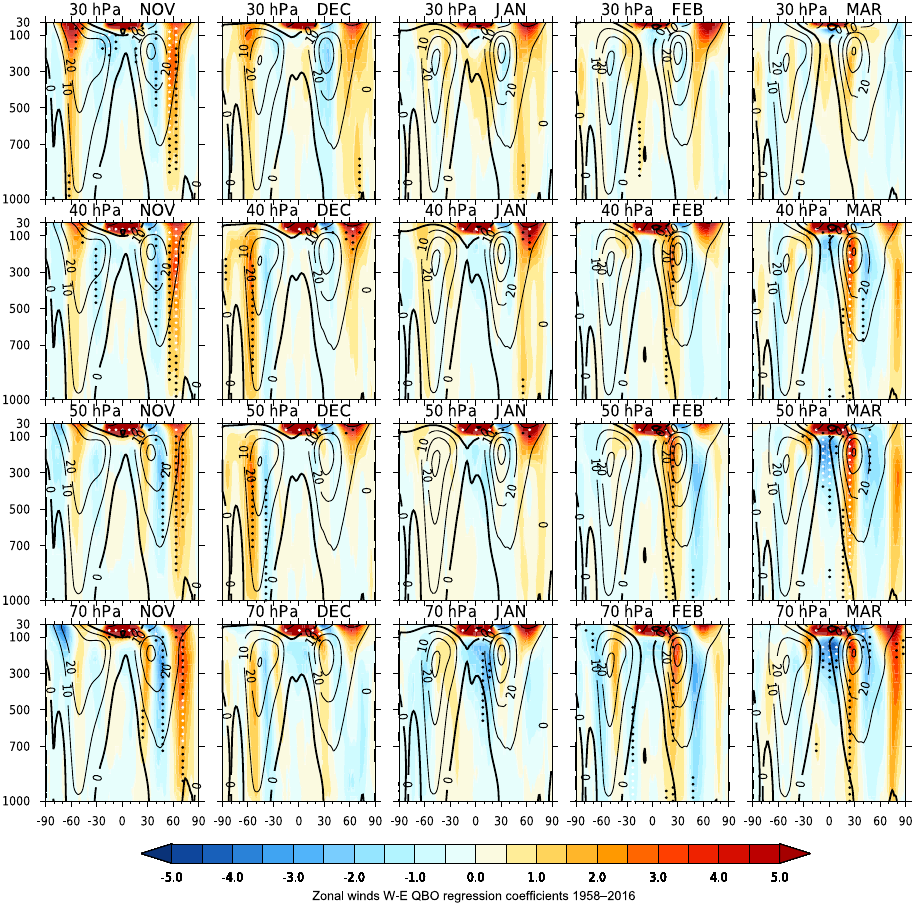
Figure 5. As Fig. 3 but using a linear height scale between 30 and 1000hPa to emphasize the tropospheric response. Note that the colour scale has been amended accordingly and results are shown for U eq = 30–70hPa only, for